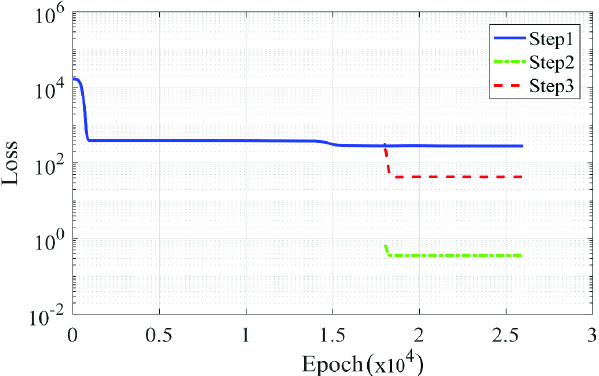
Fig. 6. Loss reduction in learning